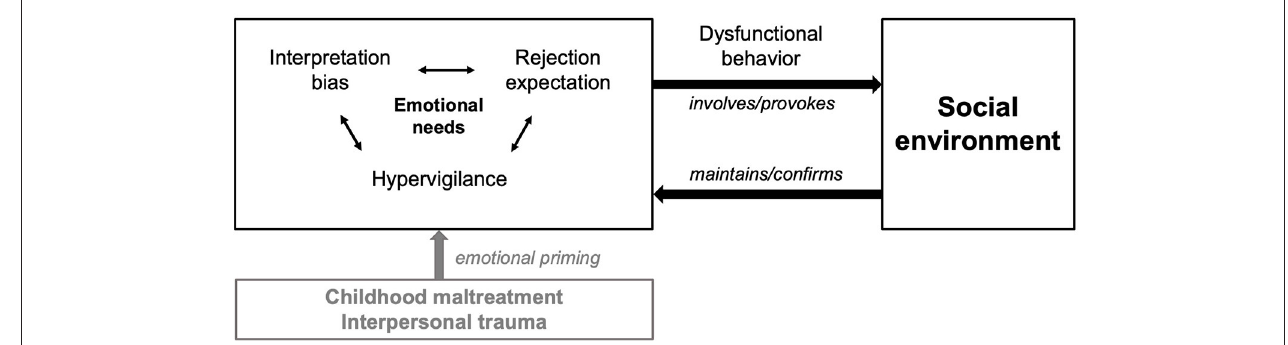
FIGURE 2 | Proposed model of loneliness in PDD and BPD. Loneliness is conceptualized as an unmet emotional need rooted in a history of childhood maltreatment, e.g., emotional abuse and neglect. The interplay of intraindividual cognitive-affective biases (esp. high rejection sensitivity, comprising hypervigilance to and expectation of rejection as well as interpretation biases) contributes to dysfunctional interaction patterns with the social environment maintaining a self-reinforcing